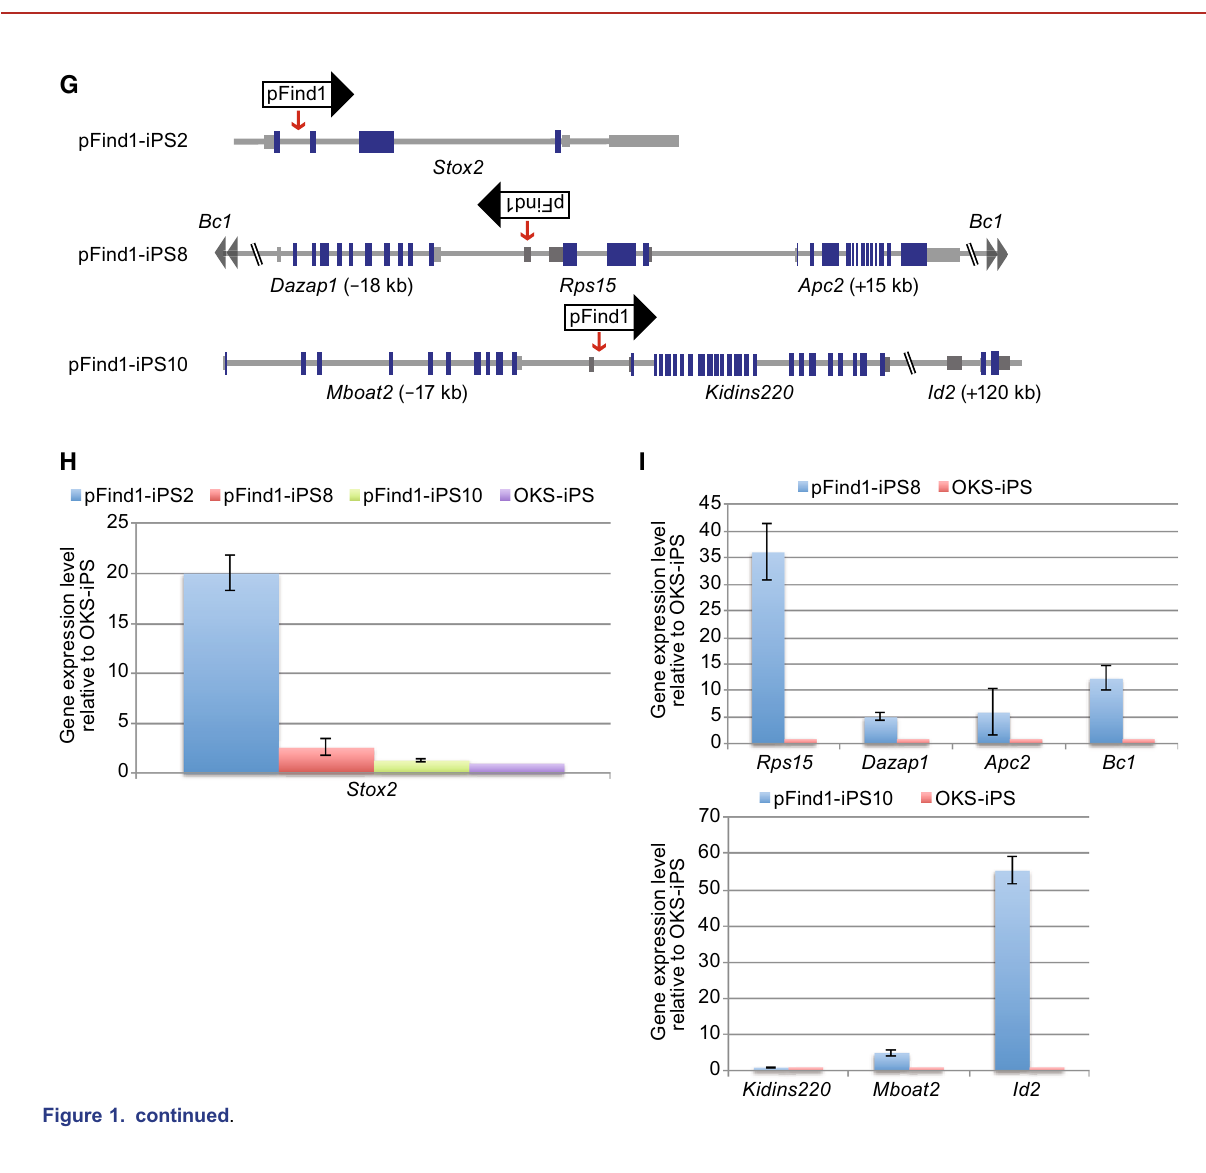
Figure 2. A large-scale screen for reprogramming regulators using OKS/pFind1 and identi fi cation of gene ’ s capacity to cellular reprogramming . (A) The distribution diagram of 21 chromosomes during the gen- eration of iPSCs. (B) Gene ontology (GO) enrichment analysis of top-ranked 1000 genes activated by pFind1. (C) KEGG pathway analysis of top-ranked 1000 genes activated by pFind1. (D) Identi fi cation of gene ’ s capacity to cellular reprogramming. Low ranking genes are labeled in blue; high ranking genes are labeled in red. E is a negative control vector that contains green fl uorescent protein (GFP) cassette. All data are represented as mean ± S. D., n = 3. Student t-tests were used for statistics. Asterisks indicate statistical signi fi cance: * P < 0.05, ** P <